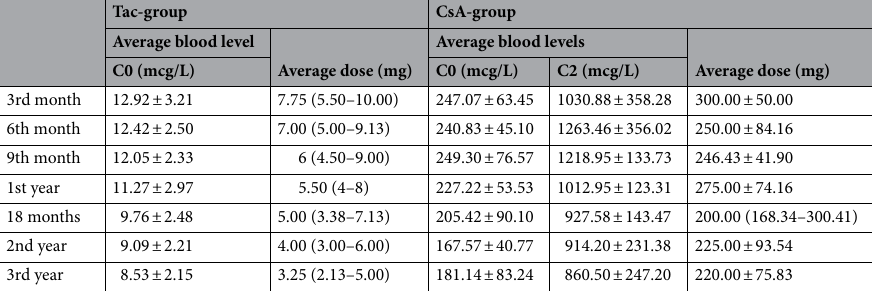
Table 3. CNI blood levels and average doses at different post-LTx timepoints. C0: trough concentration. Blood level determination immediately before the next dose of a drug. C2: blood level 2 h post-dose (in this case, 2 h post-dose of cyclosporine); CsA-group: patients undergoing immunosuppressive treatment with cyclosporine as maintenance therapy; Tac-group: patients undergoing immunosuppressive treatment with tacrolimus as maintenance